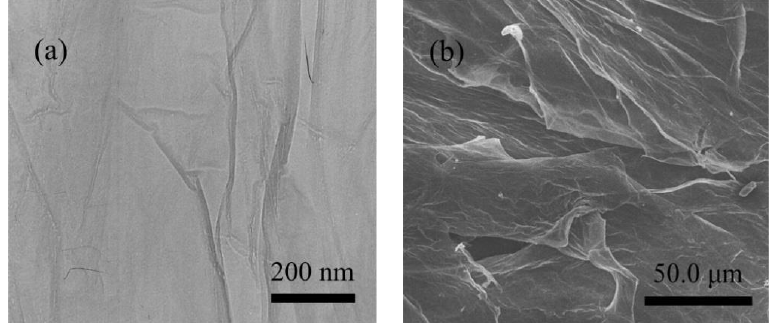
Figure 3. ( a ) Transmission electron microscopy (TEM), and ( b ) scanning electron microscopy (SEM) images of the graphene coating.